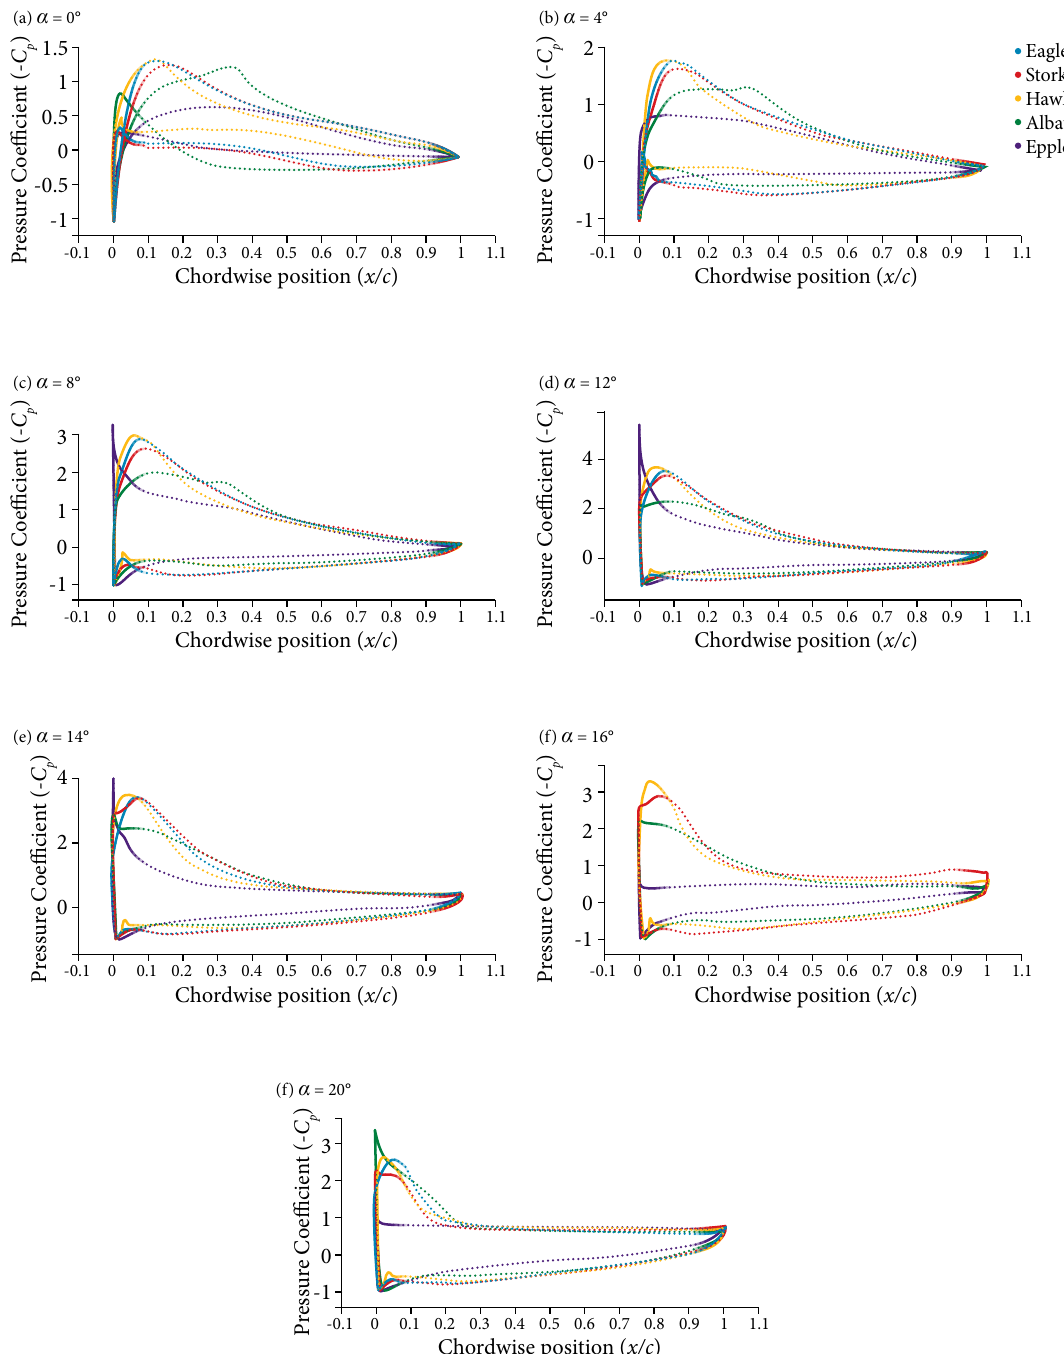
Figure 8. Pressure coefficient distribution for studied airfoils at various angles of